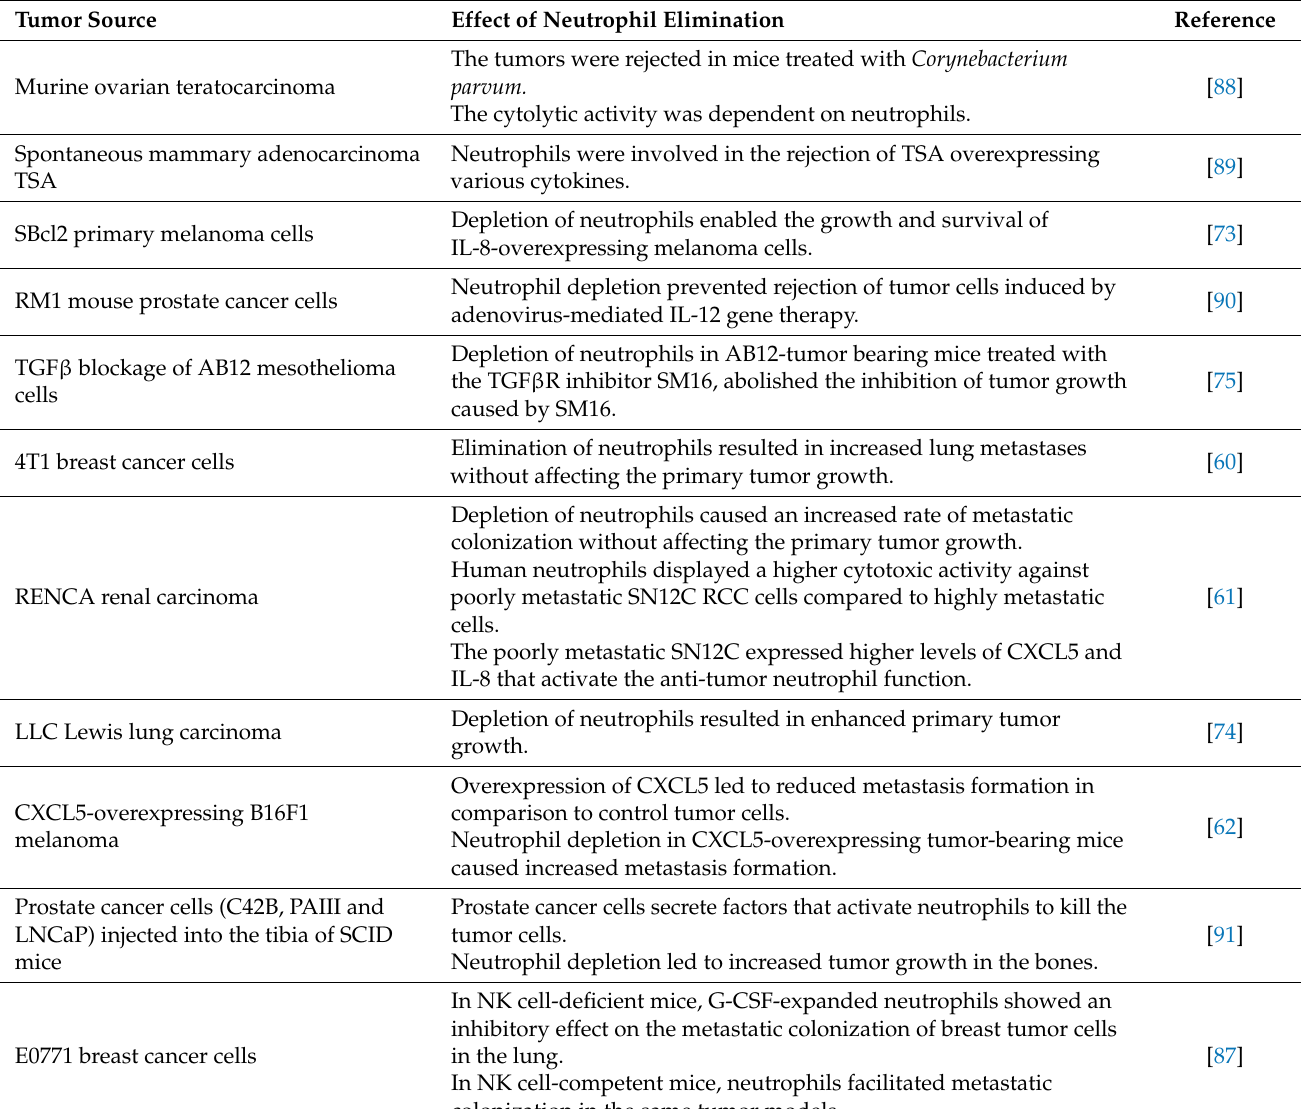
Table 2. Examples of tumor models showing anti-tumor neutrophil functions. Tumor Source Effect of Neutrophil